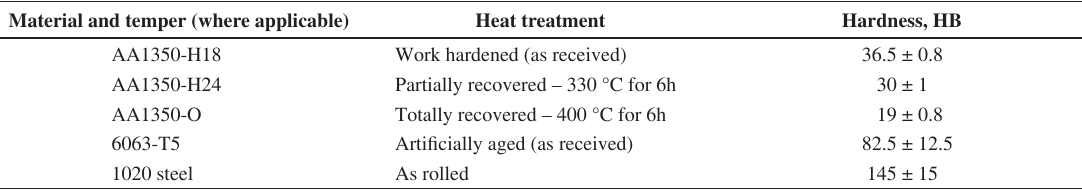
Table 2. Heat treatment and Brinell hardness for each type of material and temper (where applicable). Material and temper (where applicable)